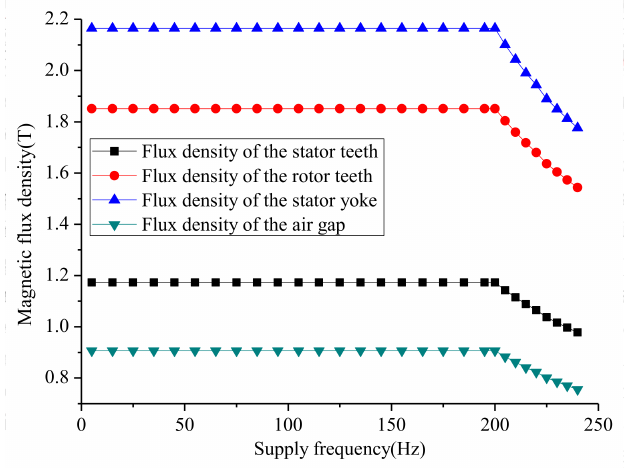
Figure 11. The curves of the magnetic flux density of each part with the supply